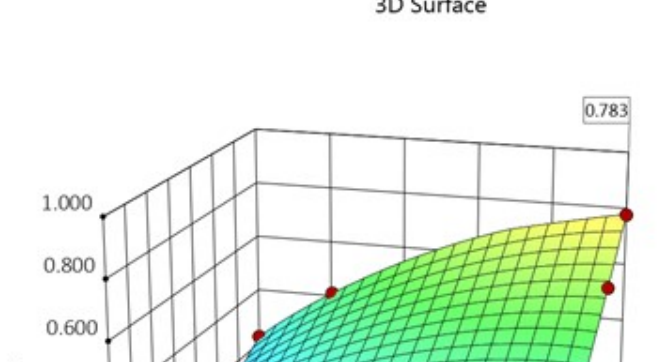
Figure 4. Klason lignin content in residual fraction in dependence of temperature and process time .